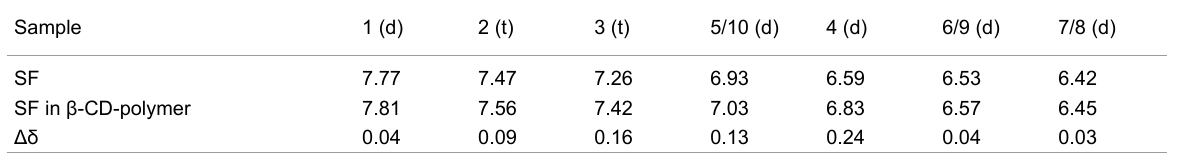
while it is insoluble in low polar solvents and at very low